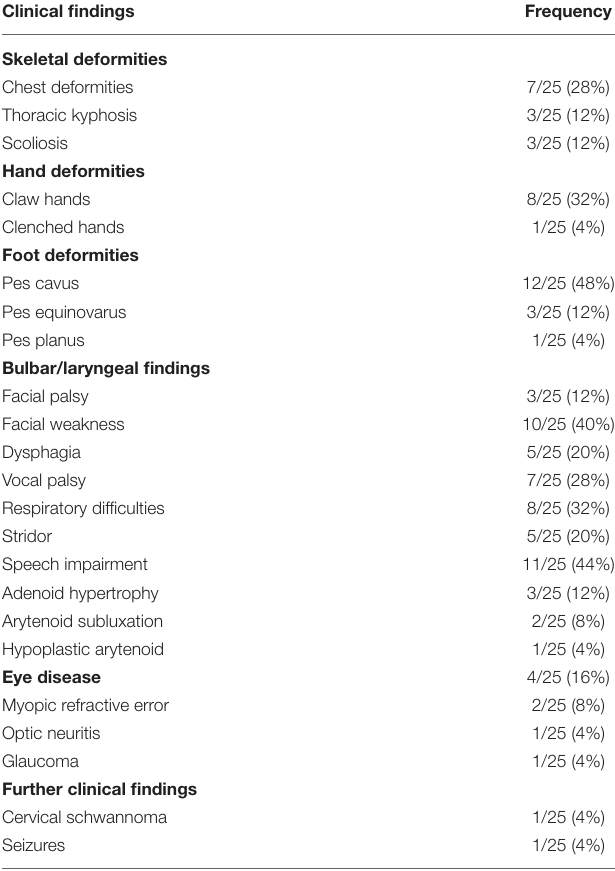
TABLE 3 | Clinical phenotype of patients with MTMR2 related Charcot-Marie-Tooth disease. Clinical